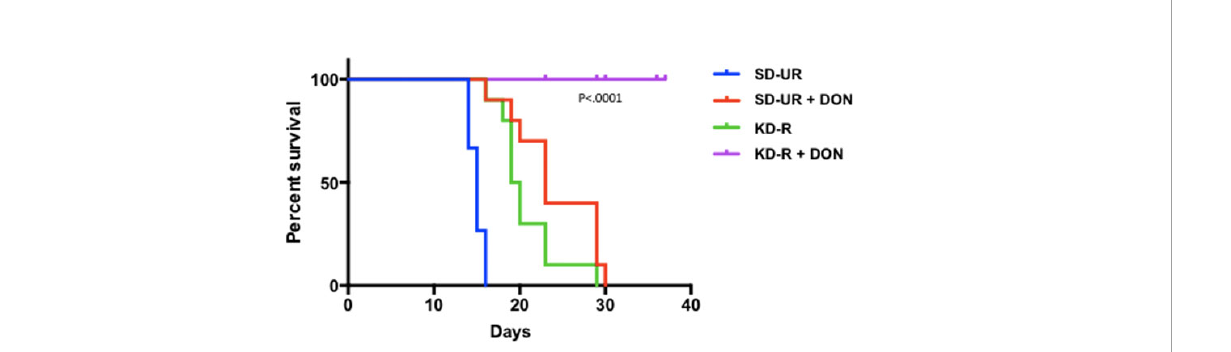
FIGURE 6 In fl uence of diet/drug therapy on overall survival of VM/Dk mice with the VM-M3 invasive GBM. A calorie restricted ketogenic diet (KD-R) was administered together with the glutaminase inhibitor, 6-diazo-5-oxo-L-norleucine (DON) as we described (13). Overall survival was signi fi cantly longer in the tumor bearing mice receiving the diet/drug combination (KD-R + DON) than in the mice receiving the standard high-carbohydrate diet (SD-UR), the KD-R alone, or DON alone. It is important to mention that 2-3x more DON was delivered to the tumor of the mice fed the KD-R than to the mice fed the SD-UR indicating that the KD facilitates a non-toxic delivery of small drug molecules through the blood brain barrier (13, 188). Image reproduced under a Creative Commons license from